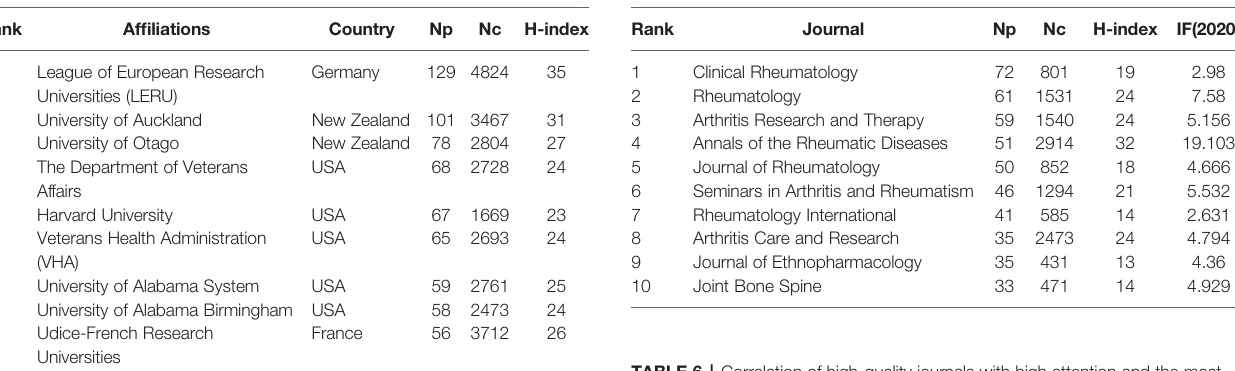
TABLE 3 | The top ten most productive af fi liations. TABLE 5 | The top ten most-published journals.